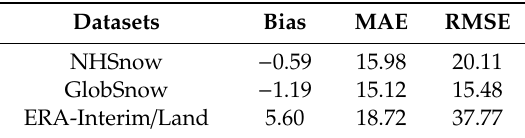
Table 4. The evaluated bias, MAE, and RMSE (unit cm) for three grid SD datasets (NHSnow, GlobSnow, and ERA-Interim /